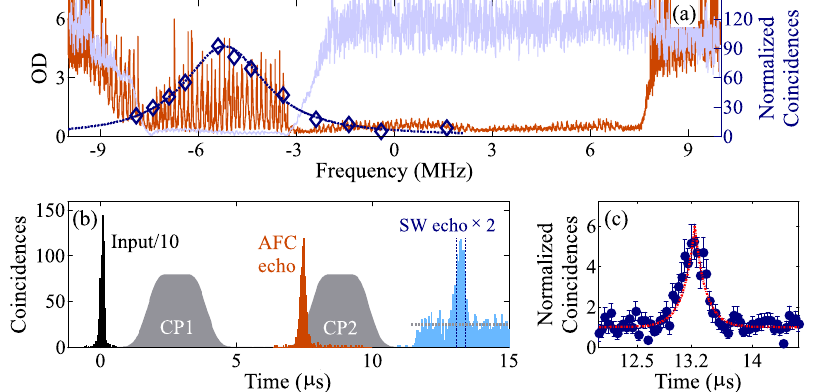
FIG. 2. (a) Example of an atomic frequency comb prepared for τ ¼ 7 . 3 μ s (red trace). The light violet trace is the transparency window that we burn in the filter crystal. The diamonds are signal-idler coincidence rates taken after preparing a single 800-kHz broad transparency window in the memory crystal and moving its frequency along the input photons. The error is smaller than the data points. The dotted blue line is a simulation of a Lorentzian peak with FWHM ¼ 2 . 8 MHz convoluted with a 800-kHz-wide spectral hole. (b) Time histograms of the input photons (black trace), the AFC echo at τ ¼ 7 . 3 μ s (red trace), and the SW echo (blue trace) acquired over an integration time of 343 min. We construct the coincidence histogram by taking the detection of the idler photons as a start and the detection of a signal photon after the memory as a stop. The coincidence count rate in the AFC echo is 4 = min and in the SW echo ≈ 1 = min. The control pulses, detected with a reference photodetector, are displayed as plain pulses and are separated by T They are modulated in amplitude and frequency with Gaussian and hyperbolic tangent waveforms, respectively, as described in Ref. [38]. The peak power is 21 mW. The dashed vertical lines indicate the integration window for the signal ( Δ T dashed horizontal line represents the noise floor. (c) Coincidence counts for the SW echo at T ¼ τ þ T average noise level, along with its fit to a double exponential function, to account for the Lorentzian spectral shape of the SPDC